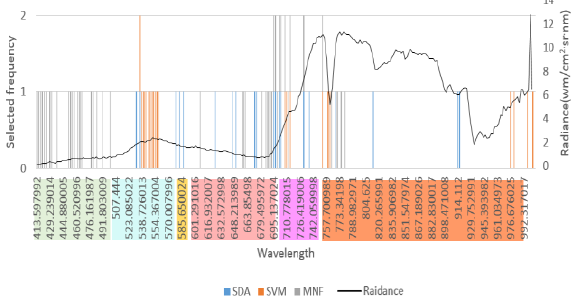
Figure 1. Important band position and selected frequency